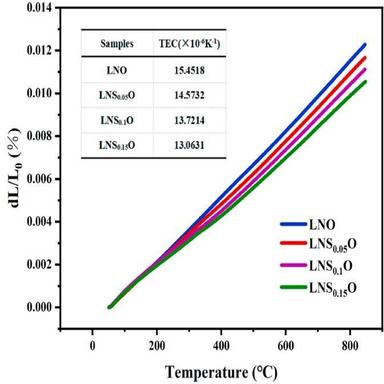
TEC of La2Ni1-xScxO4+δ(x = 0, 0.05, 0.10 and 0.15) samples.